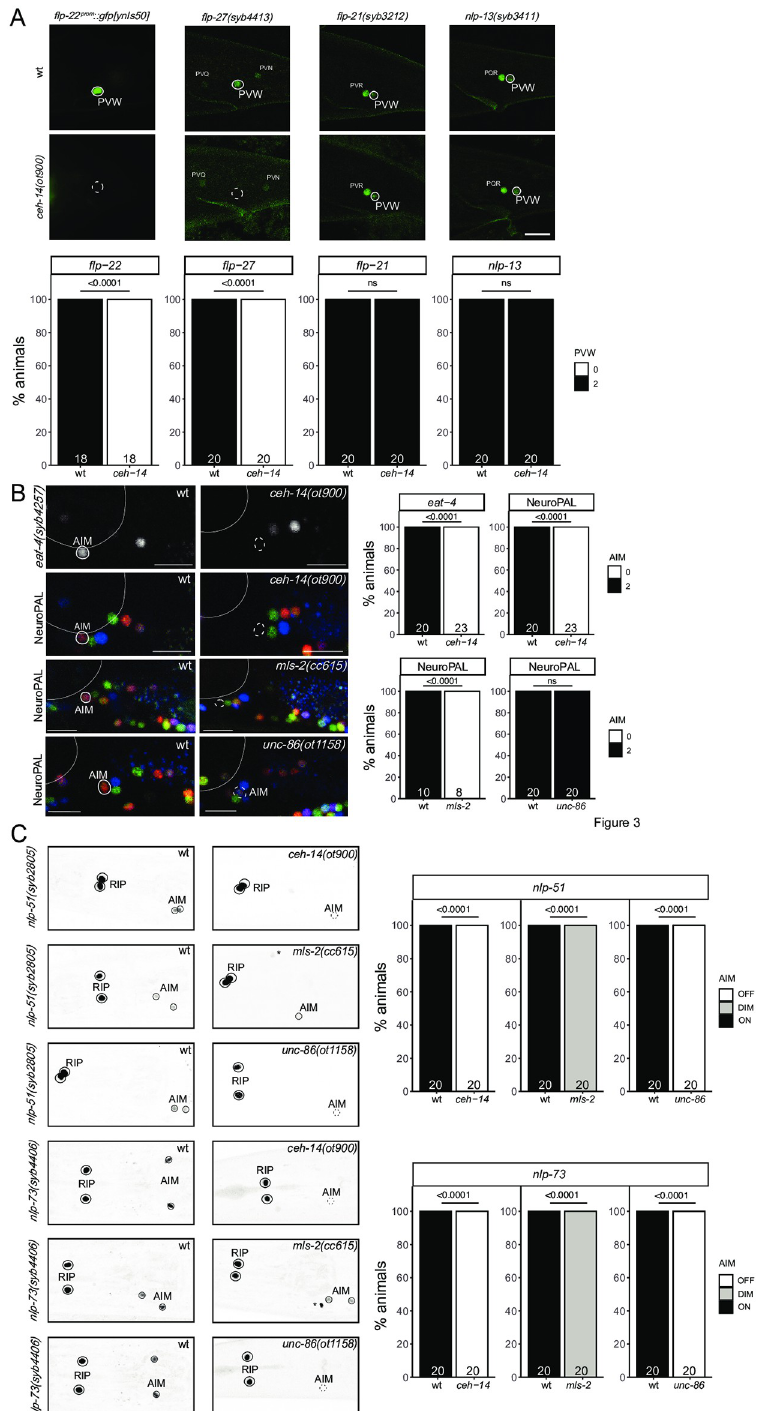
Fig 3. ceh-14 affect differentiation of several neuron classes, in combination with different homeobox genes. Fig 3A: ceh-14(ot900) mutant animals show a loss of neuropeptide-encoding gene expression in PVW, including a promoter fusion reporter transgene for flp-22 ( ynIs50 ) and a flp-27 CRISPR reporter ( syb4413 ), while expression of the neuropeptide CRISPR reporters for flp-21 ( syb3212 ) and nlp-13 ( syb3411 ) is unaffected. Neuron of interest is outlined in solid white when expressing wildtype reporter colors, and dashed white when one or all colors are lost. Representative images of wild type and mutant worms are shown with 10 μ m scale bar. Graphs compare expression